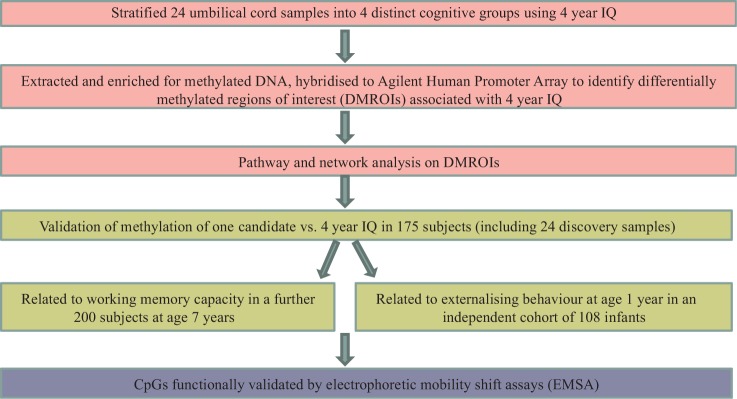
Overview of study.